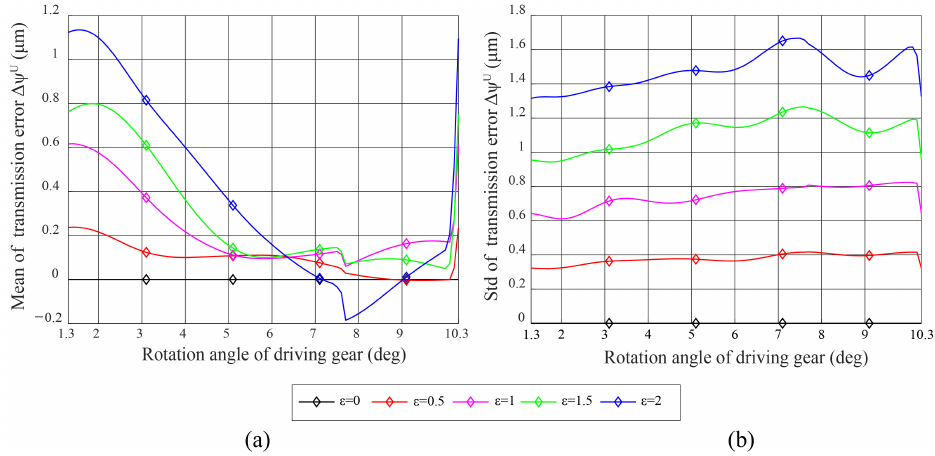
Figure 10. ( a ) Mean and ( b ) standard deviation (std) of transmission error under unloaded condition. When the machining error ( (cid:101) ) increases, there is no thermal deformation or pitch error ( η = 0, e p = 0 )